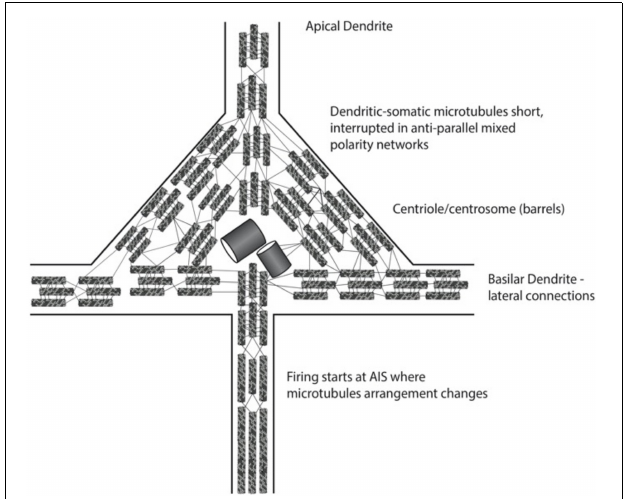
FIGURE 11 | Schematic of portion of layer V giant pyramidal neuron, with cone-shaped cell body. An apical dendrite arises to the cortical surface and is a source of electroencephalography (EEG). Basilar dendrites extend laterally to other pyramidal dendrites (not seen). A single axon extends downward, conveying action potential firings, or spikes which can exert volitional, causal